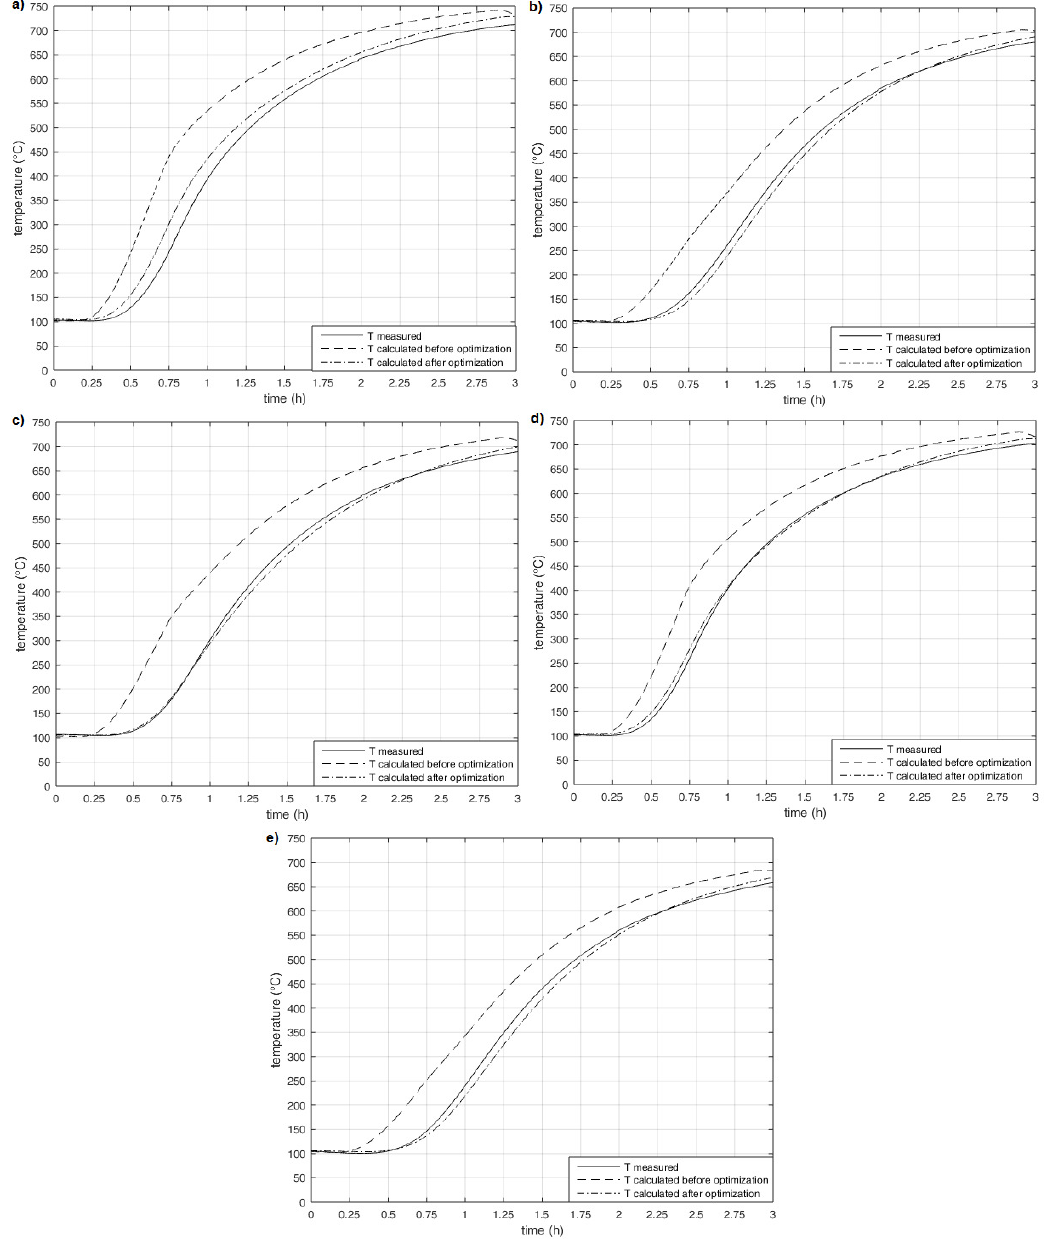
Figure 11. Comparison of direct measured temperature (T measured) to indirect measured temperature before (T calculated before optimization) and after (T calculated after optimization) optimization for temperature ( a ) T 1 , ( b ) T 2 , ( c ) T 3 , ( d ) T 4 , and ( e ) T 5 of laboratory measurement